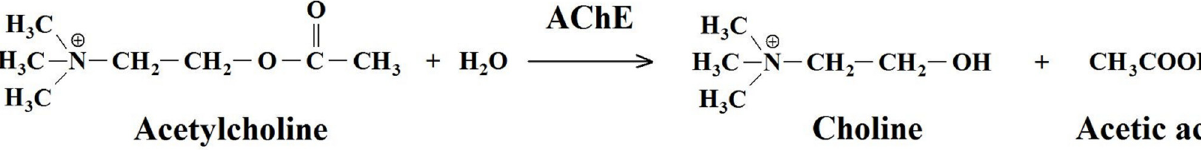
Figure 1. Scheme of acetylcholine decomposition reaction catalyzed by acetylcholinesterase (AChE).